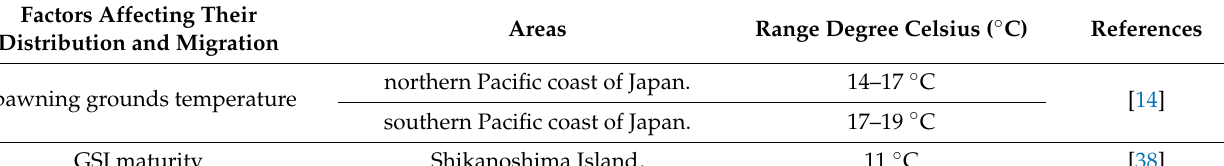
Table 1. Factors affecting the distribution and migration of Japanese sardine in their habitats of occurrence. Factors Affecting